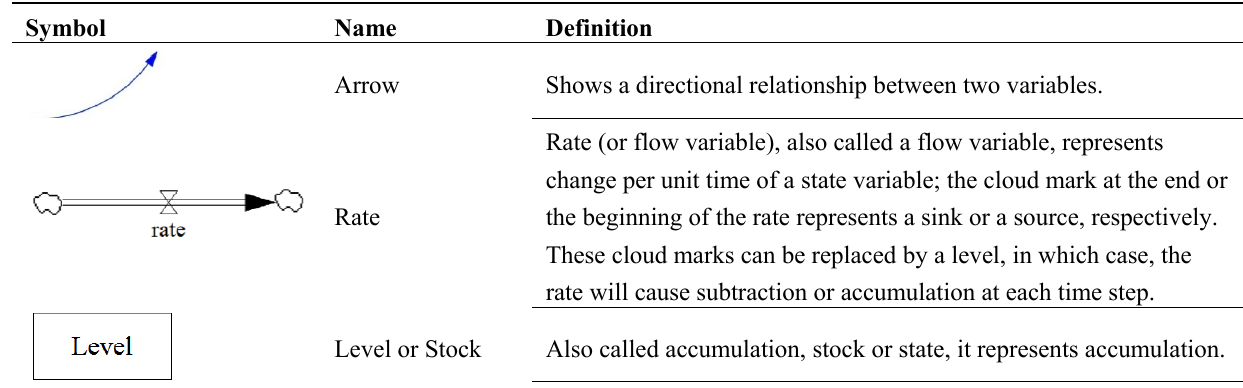
Table 1. Basic components of system dynamics